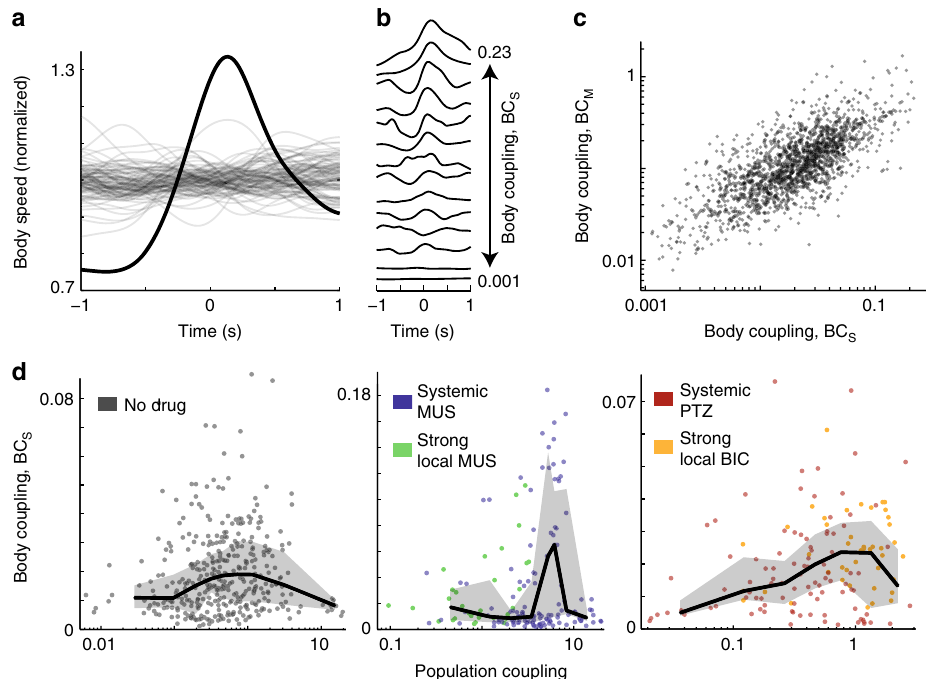
Fig. 5 Body coupling BC S peaks at optimal weak population coupling. a As an alternative way to quantify body coupling, we de fi ne BC S as the SD of the spike-triggered-average body speed (STABS) waveform. The STABS waveform is normalized by its mean value. Gray lines represent 100 surrogate STABS waveforms based on temporally shifted spike times. b Example STABS waveforms for 14 units illustrate strong (top) to weak (bottom) body coupling. c Units with high BC M tended to have high BC S . d A peaked relationship was found between BC S and population coupling. Line is a moving average. Gray shaded region delineates